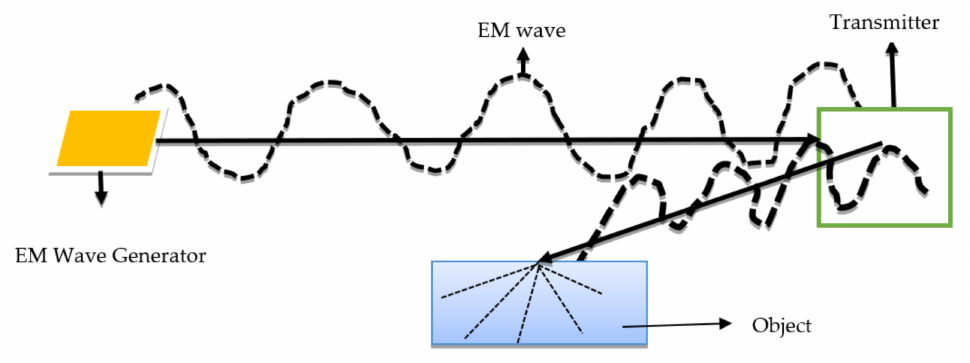
Figure 5. Electromagnetic waves propagation